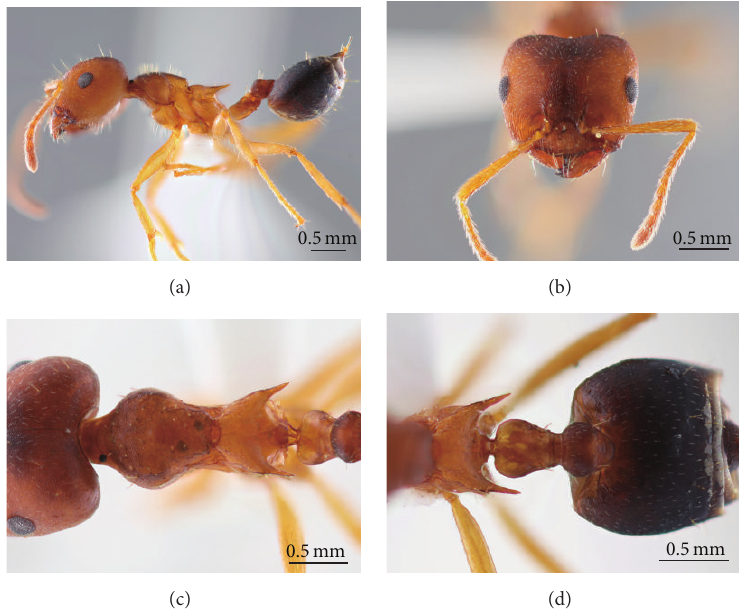
Figure 1: Crematogaster coriaria Mayr, 1872, worker. (a)–(d) Large worker (HW 1.39; WL 1.52) (Ulu Gombak, Selangor, Malaysia): (a) body in lateral view; (b) full-face view of head; (c) dorsal view of mesosoma; (d) petiole and postpetiole in dorsal view.